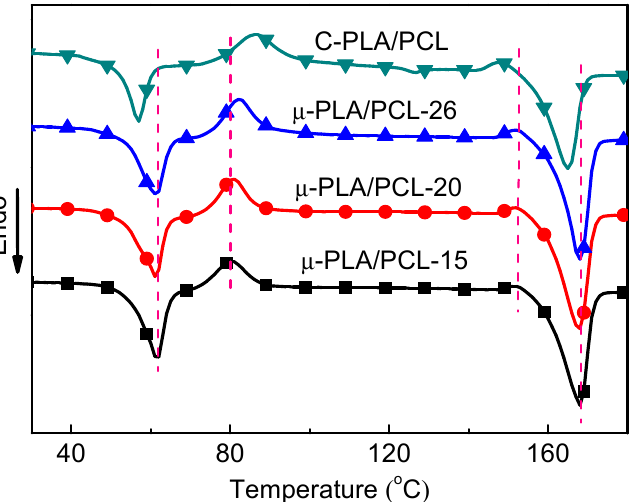
Figure 4. The Differential Scanning Calorimetry (DSC) heating curves of microparts with different cavity size and macropart. Table 3. The DSC parameters of microparts with different cavity size and macropart.